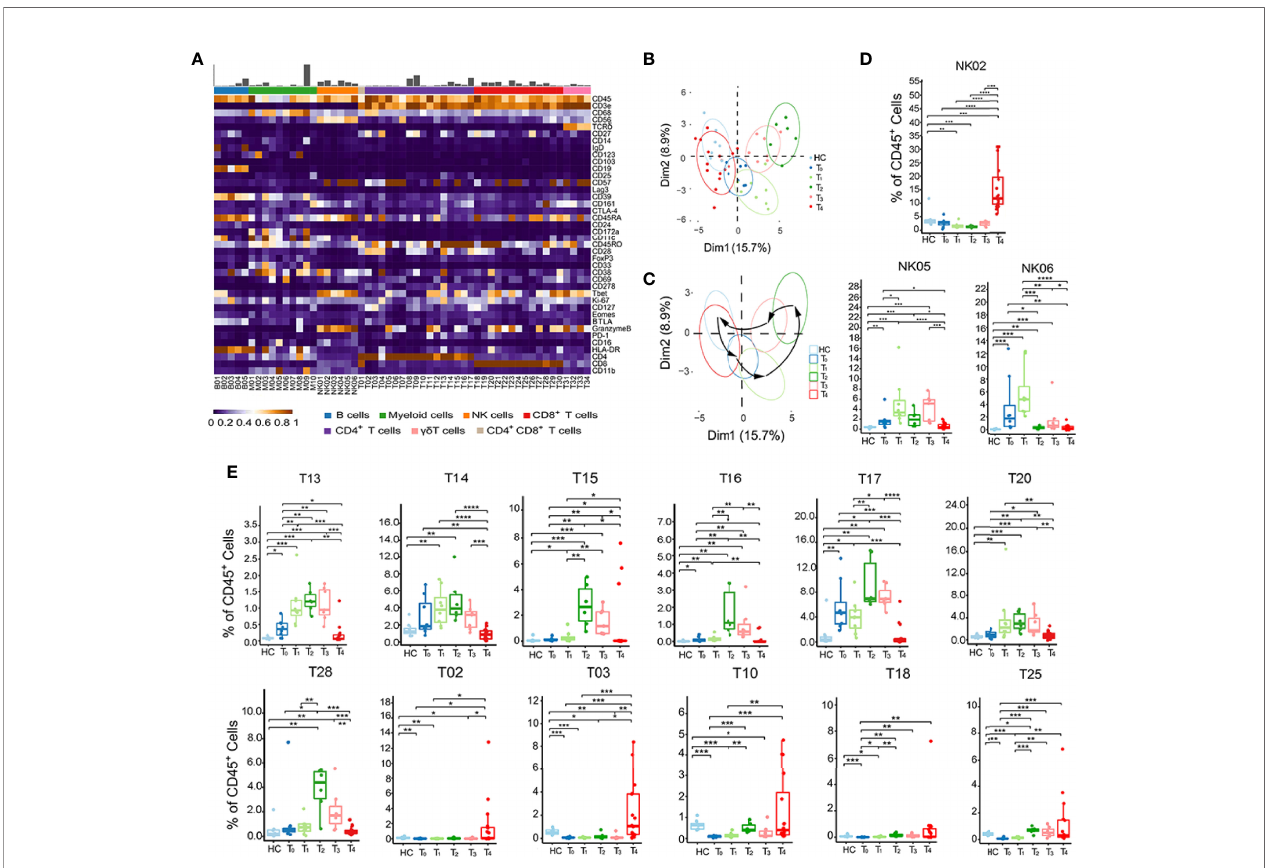
FIGURE 2 | Identi fi cation of dynamic signatures of each immune subset. (A) Heatmap showing the normalized mean expression of 40 membranous or intracellular markers to identify the phenotypes of the main six immune cell clusters. We characterized fi ve B cell clusters (B01 – B05), 10 myeloid cell clusters (M01 – M10), six NK cell clusters (NK01 – NK06), 16 CD4 + T cell clusters (T02 – T17), 13 CD8 + T cell clusters (T18 – T30), four gd T cell clusters (T31 – T34). Relative frequency was shown as a bar graph on the top. (B, C) Principal component analysis (PCA) showing (B) the distinct immune signatures among HC and patients with each time point from T 0 to T 4 . (C) Black arrows indicate the rhythmic changes with the disease development. (D, E) Boxplots revealing the dynamic characteristics and frequencies of different immune cell clusters, NK cells shown in (D) and T cells shown in (E) . *P < 0.05, **P < 0.01, ***P < 0.001, **** P <